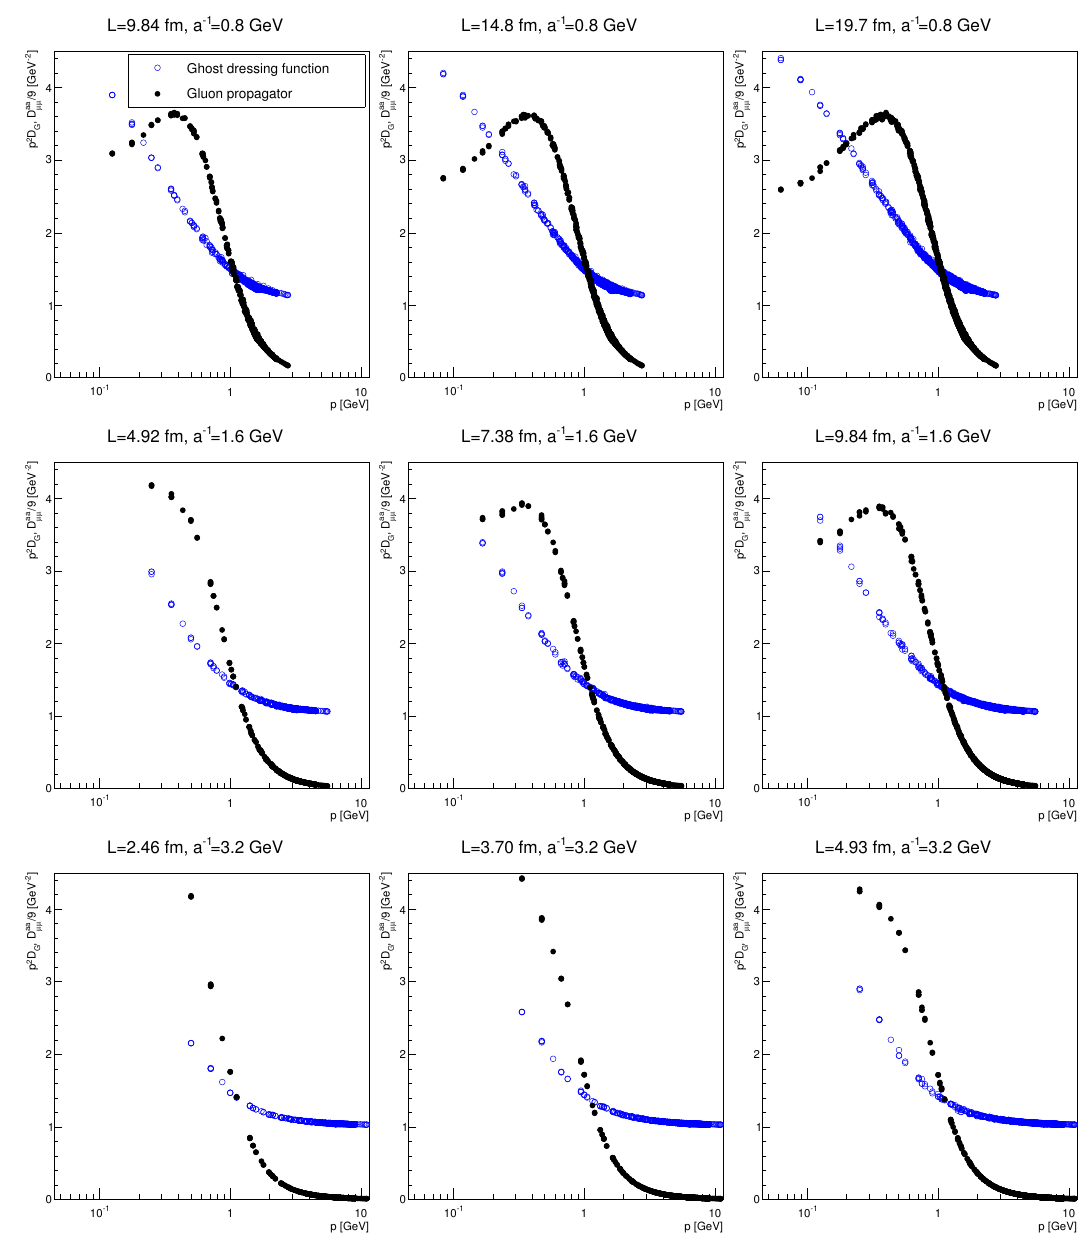
Figure 9: The ghost dressing function and the gluon propagator for the different lattice settings in three dimensions. Lattice volume increases from left to right and the latte spacing decreases from top to bottom. Results are along all possibles axes [ 40 ] . Errors are smaller than the symbol sizes, and the same number of configurations have been used in both